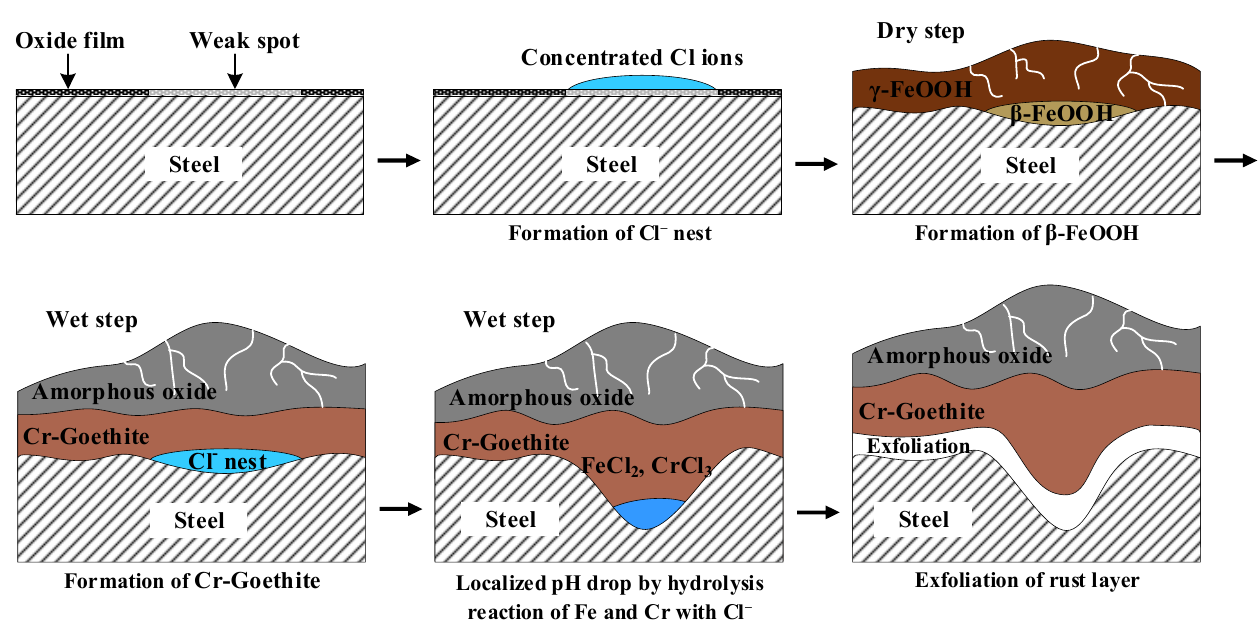
Figure 11. Schematic diagram of the mechanism of localized corrosion of Cr-added steel under wet/dry conditions.